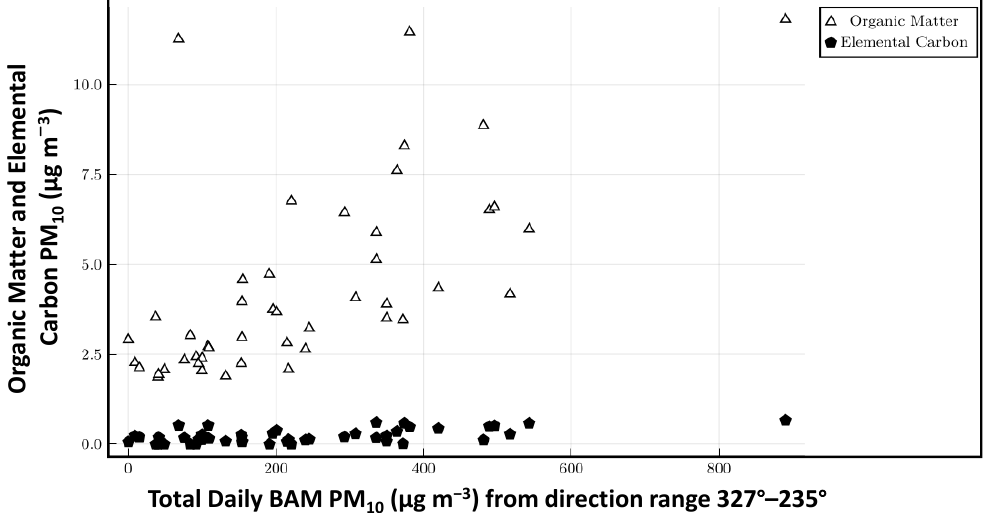
Figure 16. The relation between the OM and EC components of the PM 10 and the total daily PM 10 calculated from the BAM for all the valid sampling days from April to October 2021.